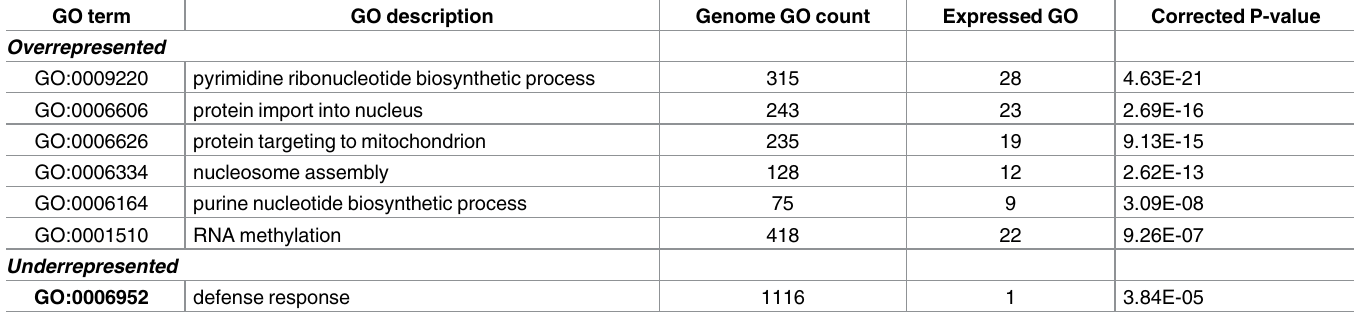
Table 3. GO enrichment analysis of the differentially expressedtranscripts that are significantly higher at stage 9 compared to 7.2 after drying and not induced upon drying between 7.2F and 7.2D. GO